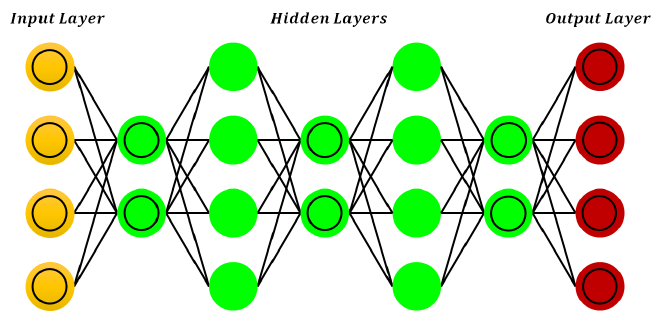
Figure 6. A general architecture of the Deep Belief Networks